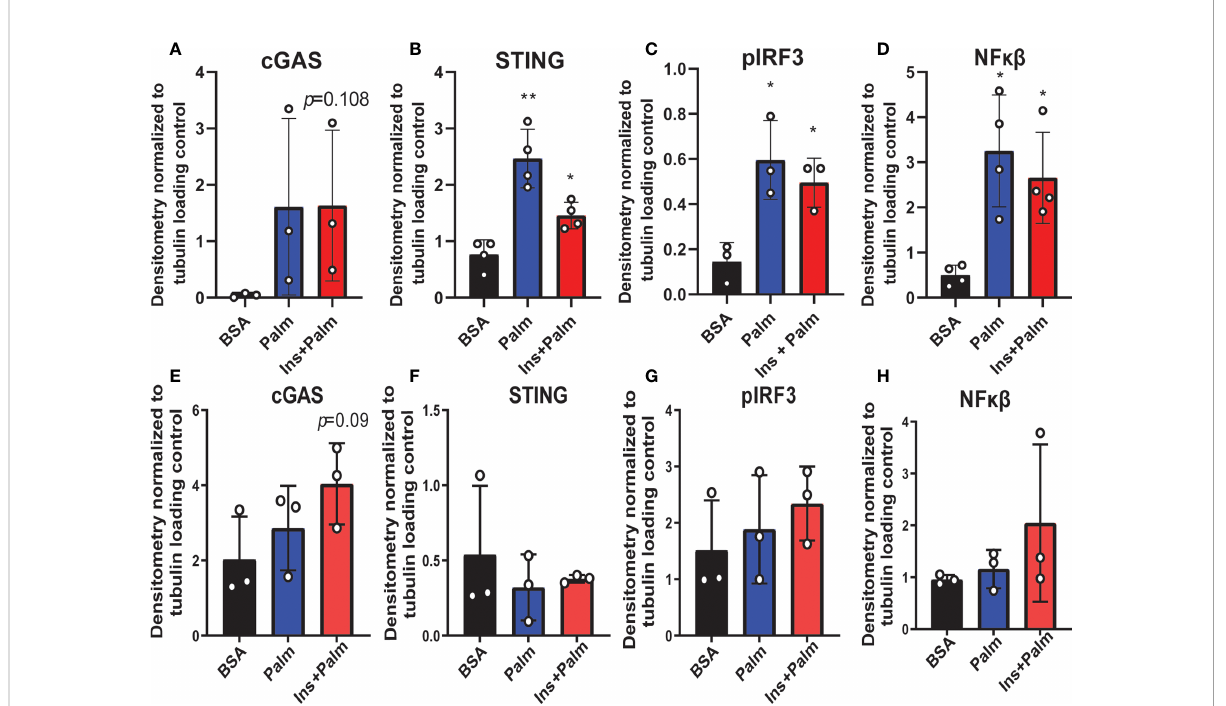
FIGURE 6 Neuronal and microglial cGAS/STING protein expression. Expression in a human microglial cell line (n=3 biological replicates, A-D ) and a human hippocampal neuronal cell line (n=3 biological replicates, E-H ) treated with either palmitate alone (Palm; HHi=250 m M, MG=62.5 m M, 24h) or a combination of insulin and palmitate (Ins+Palm; above concentrations of Palm+50nM insulin, 24h). Relative protein expression quanti fi ed as average band intensity relative to tubulin loading control; * p <0.05, ** p